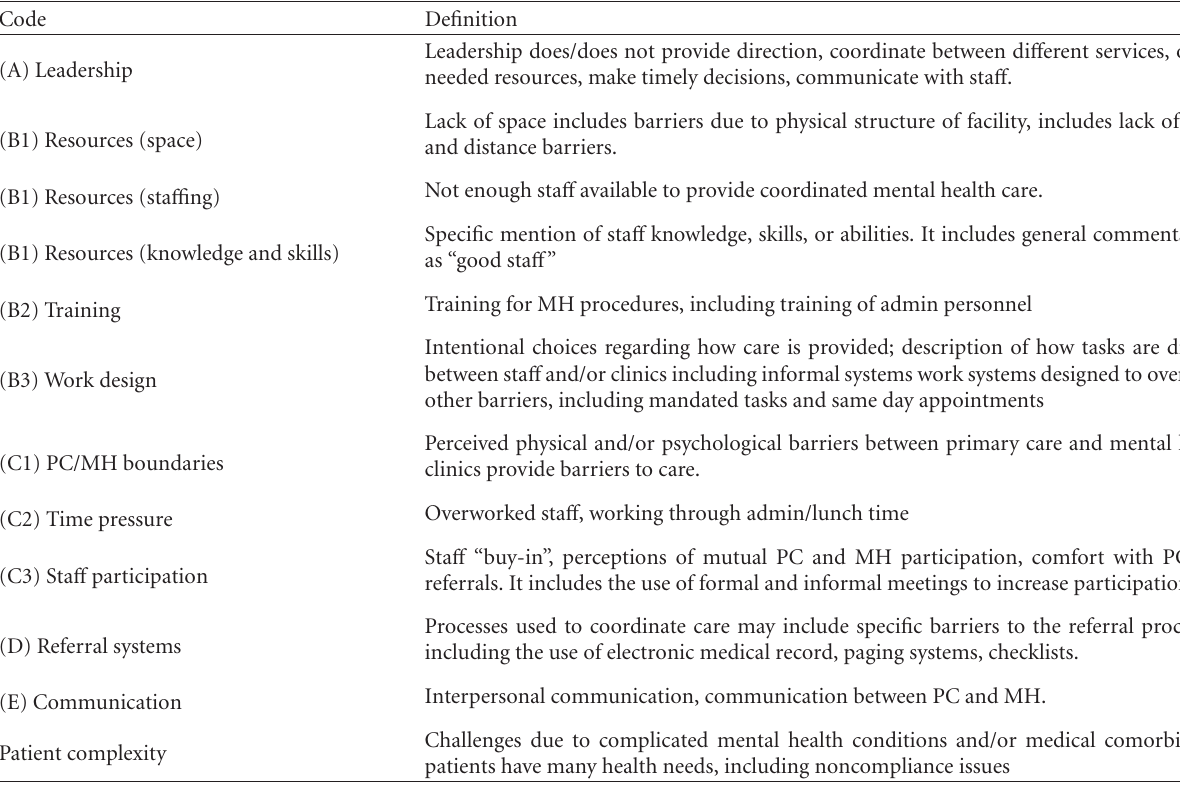
Table 3: Emergent